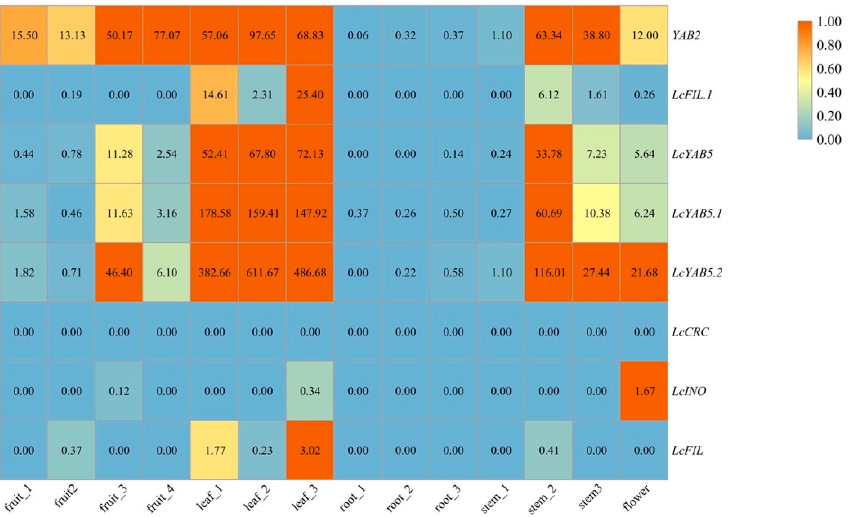
Figure 9. Gene expression profiles for the YABBY gene family in Litsea . The color scale above represents expression values in various organs, respectively.